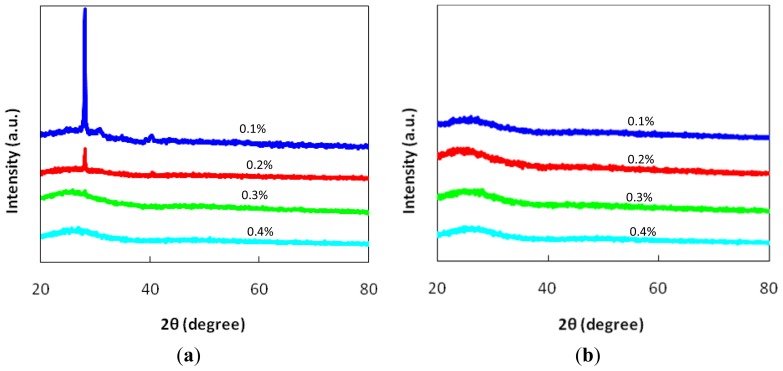
The XRD pattern of (a) the original sample and (b) the remelted MnO–B2O3–TeO2 glass samples.